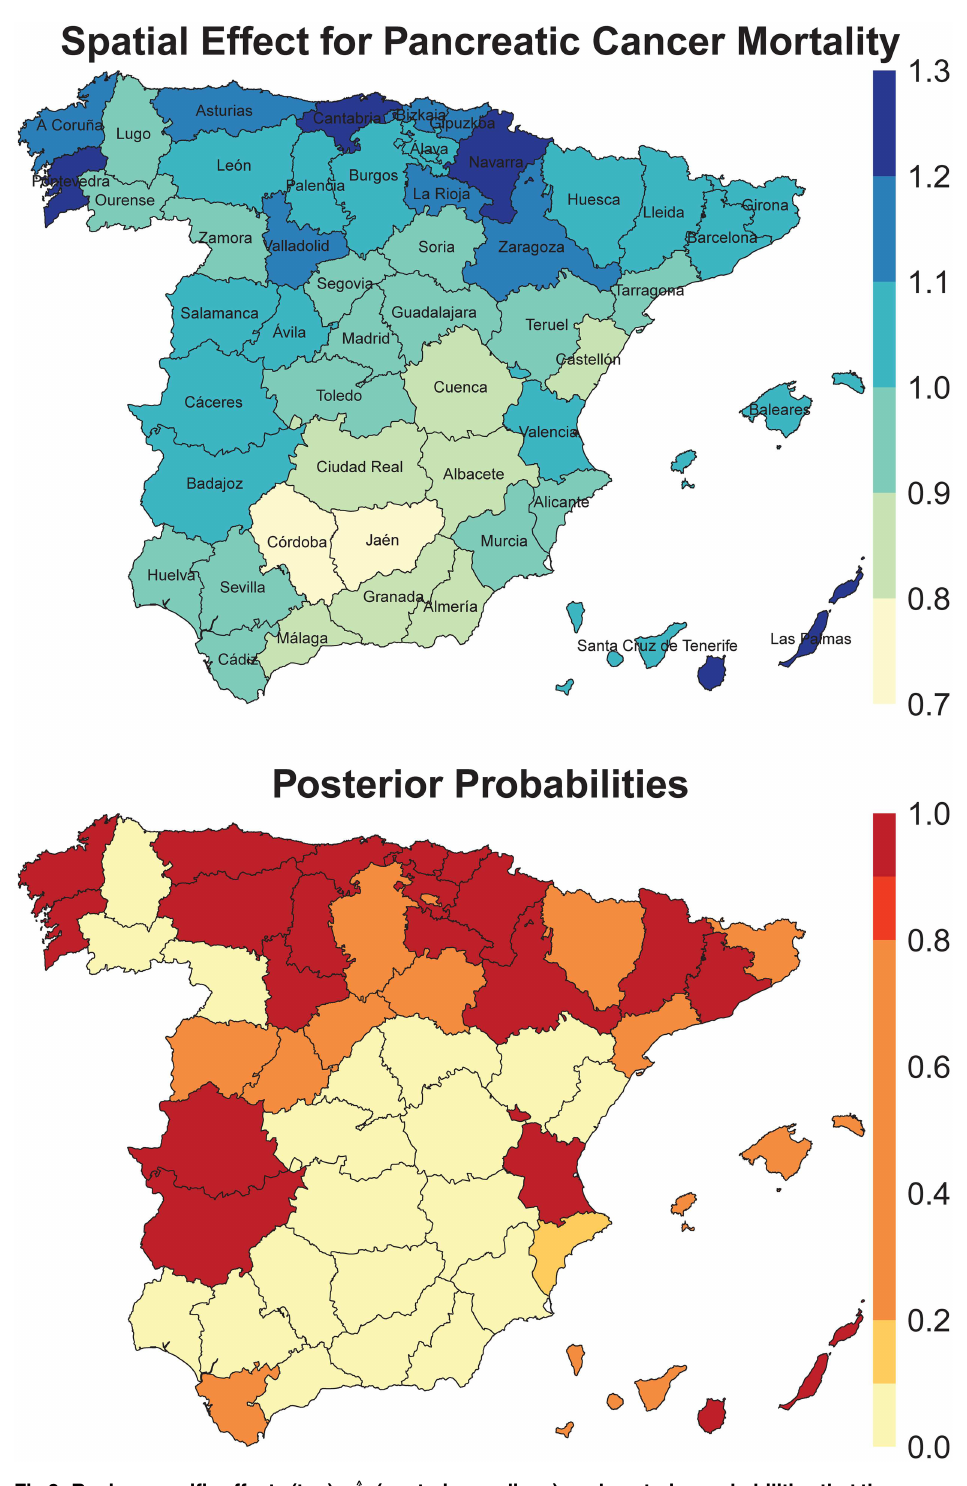
Fig 3. Region-specific effects(top), e ^ ϕ a (posterior medians), and posterior probabilities that the region effect is greater than one, P ð e ^ ϕ a > 1 Þ